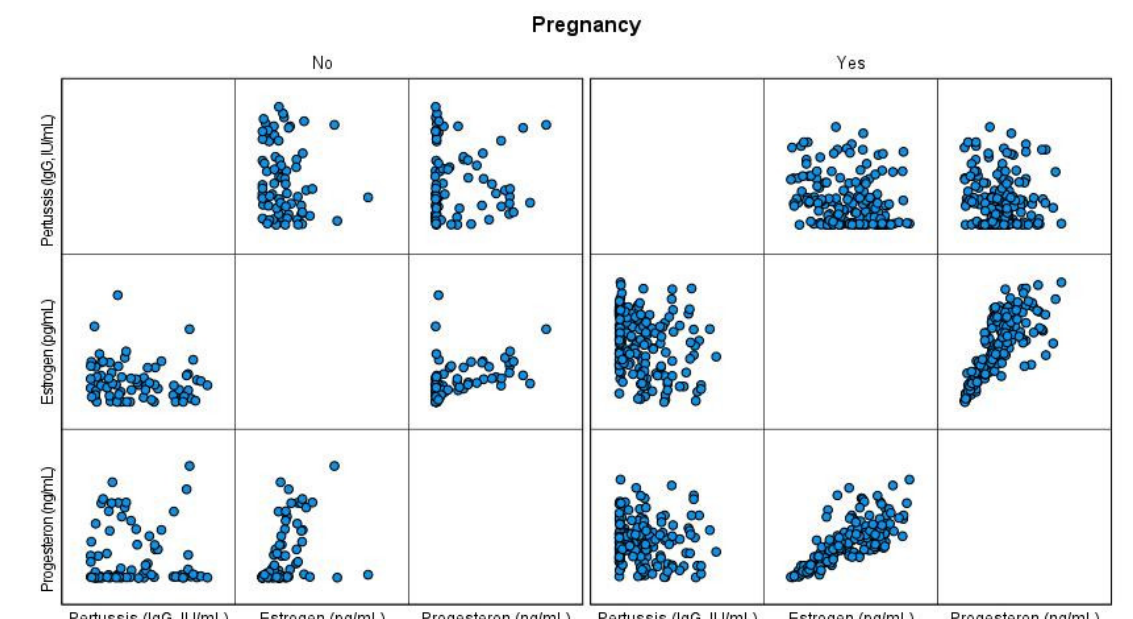
Figure 1. Scatter plot for anti-PT IgG antibody, estrogen and progesterone levels for pregnant and non-pregnant women.